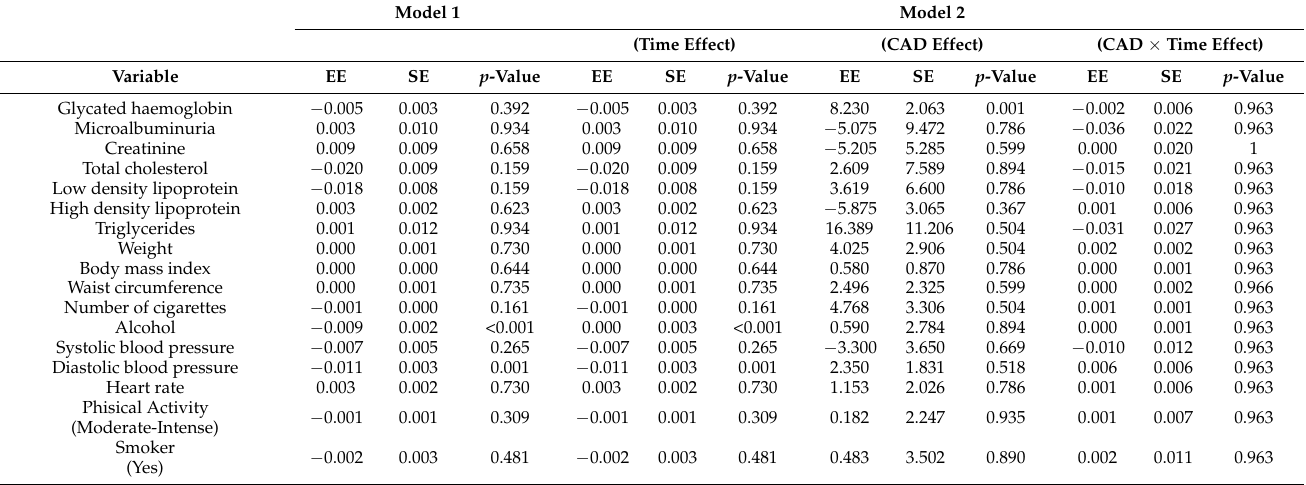
Table 4. Estimated change of biochemical and clinical variables from baseline to follow-up. Model 1 included only time as covariate. Model 2 included time and CAD enrollment as covariates and calculated the effects of variables separately (time effect and CAD effect), and in case of interaction (time × CAD